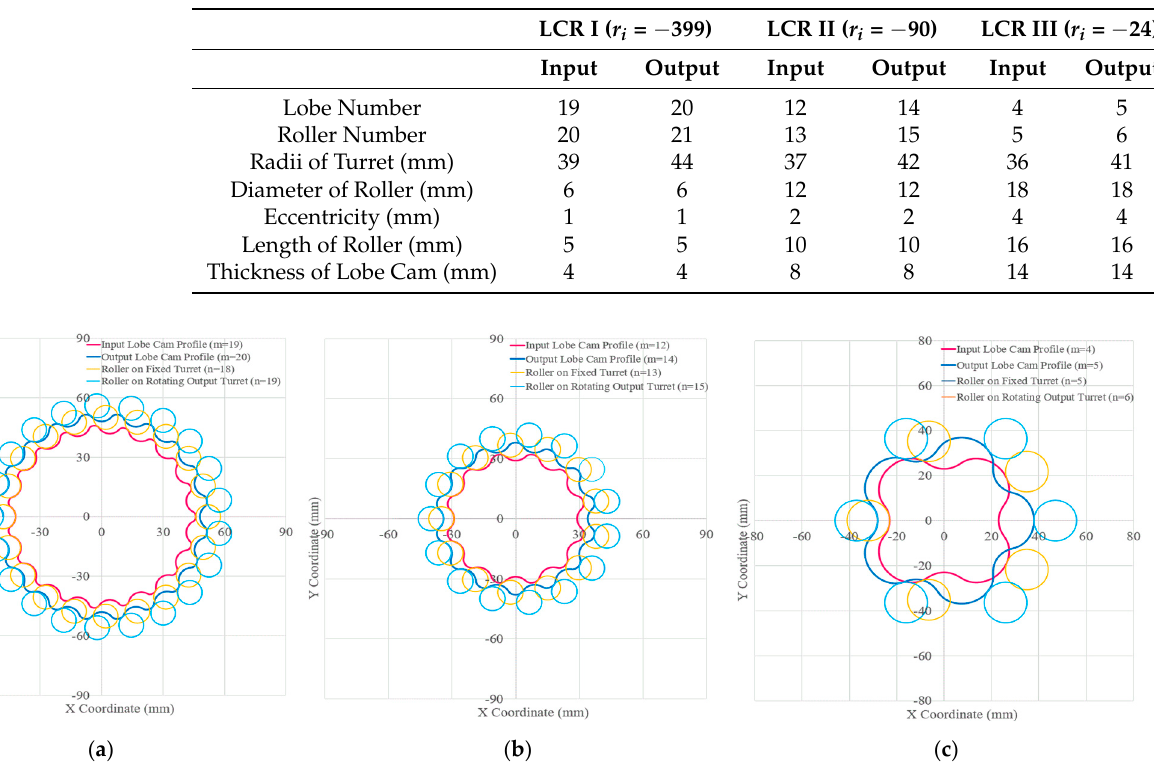
Figure 5. Lobe cam profiles for LCRs I, II, and III: ( a ) LCR I ( ri = − 399); ( b ) LCR II ( ri = − 90); ( c ) LCR III ( ri = − 24).